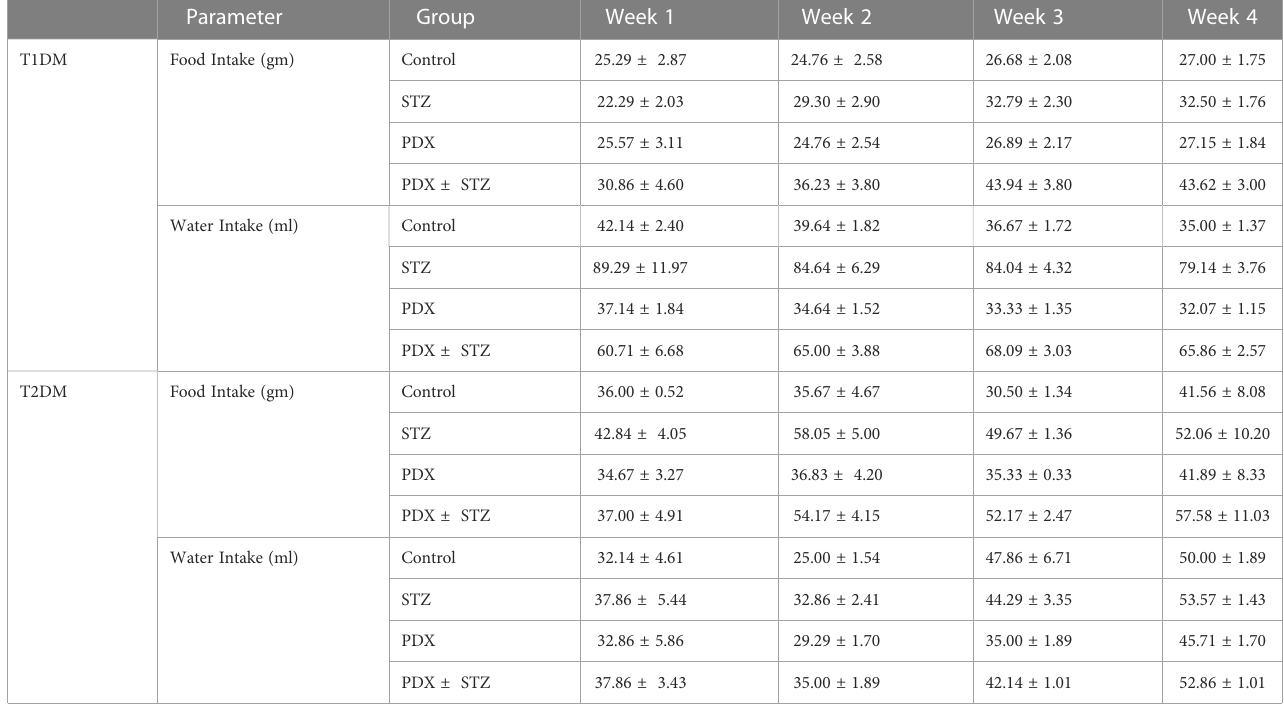
TABLE 5 Measurement of food and water intake of Type 1 DM and Type 2 DM